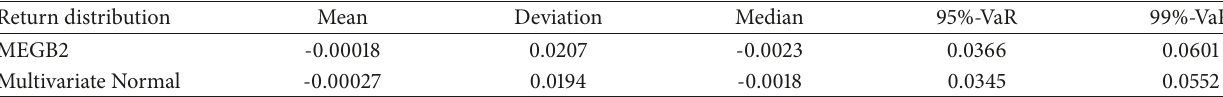
Table 4: The descriptive statistics of P&L.